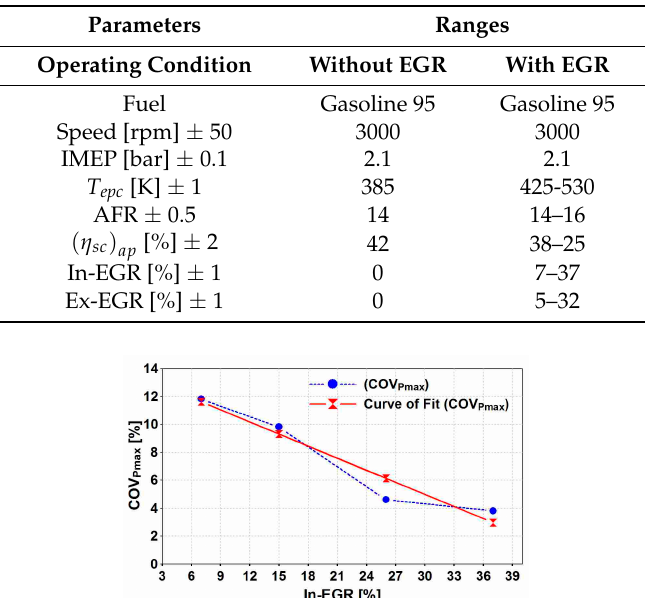
Figure 7. Cyclic variation of CA10, IMEP and P max with EGR utilization (rpm = 3000, IMEP = 2.1 bar, T epc = 451 K, In-EGR = 10 %, Ex-EGR = 4 %). Table 3. Engine operating conditions for cyclic variability investigation.